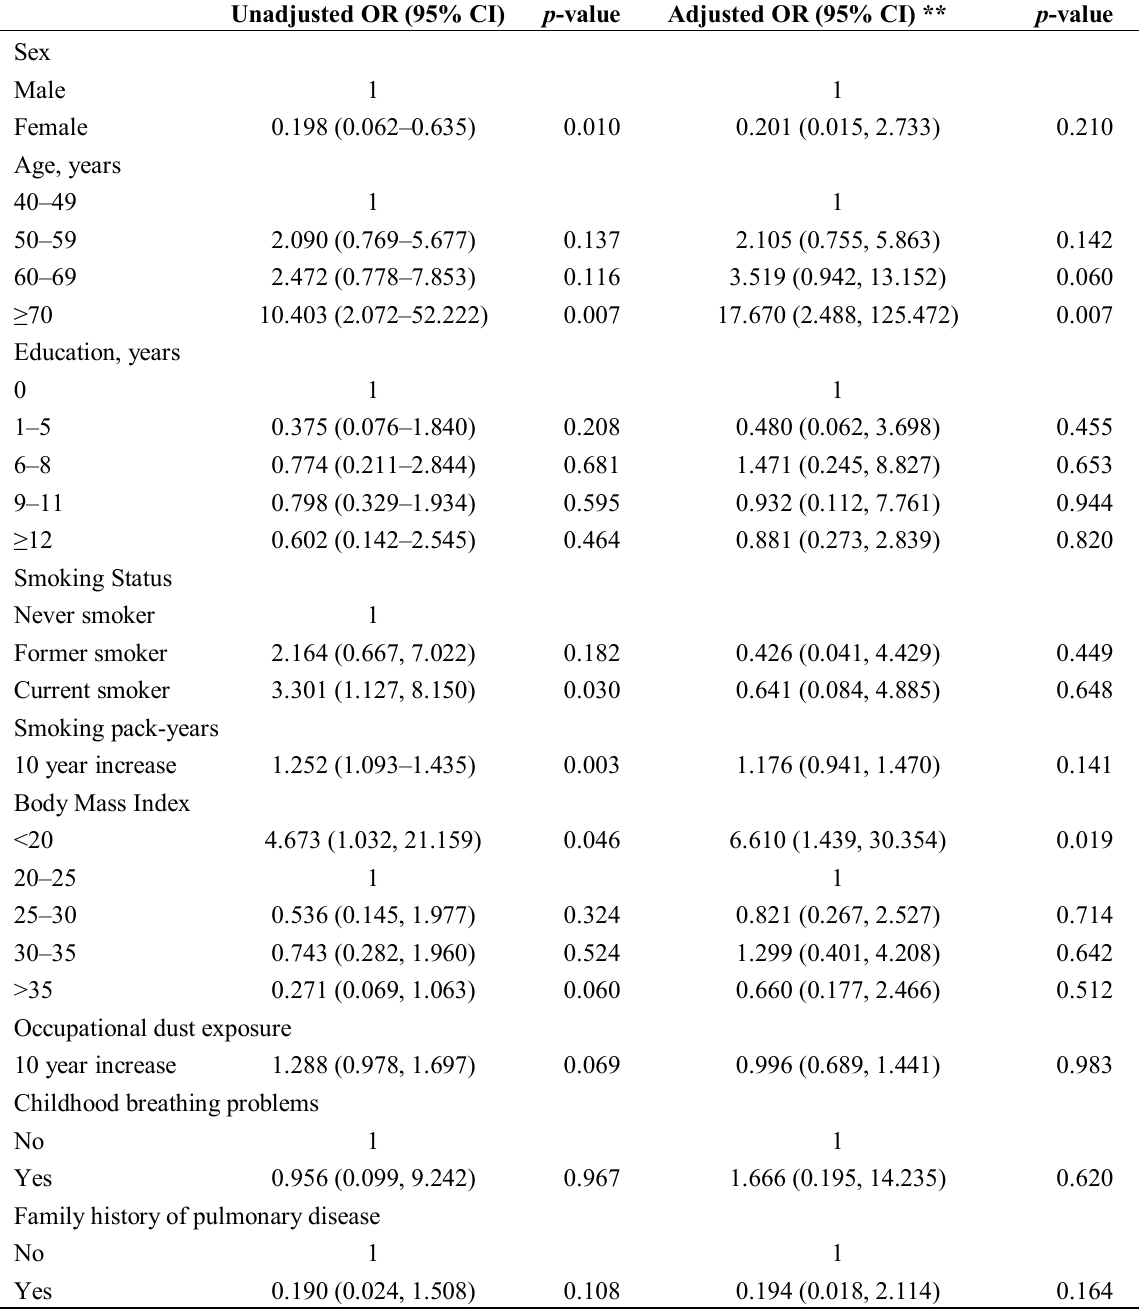
Table 3. Factors associated with COPD *